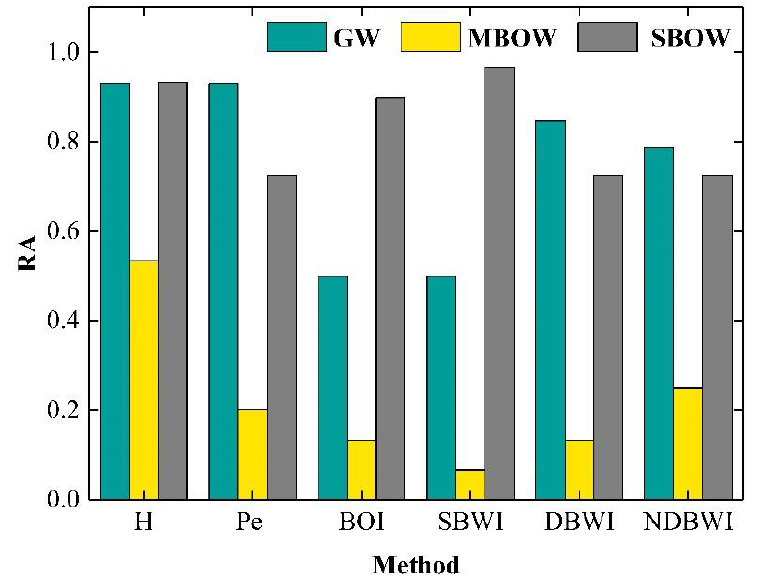
Figure 5. Identification accuracy of models.